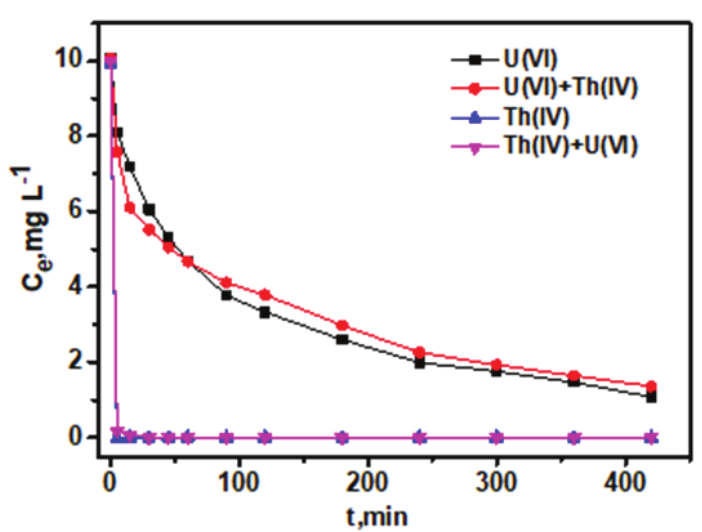
Figure 7. U(VI) and Th(IV)-spiked ground water adsorption kinetic using PGO–Gd.